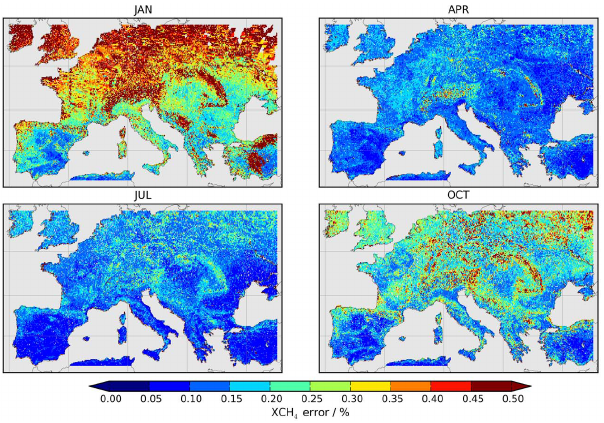
Figure 7. Relative XCH 4 noise error among the European trial en- semble expected from G3E for the months January (JAN), April (APR), July (JUL), and October (OCT).